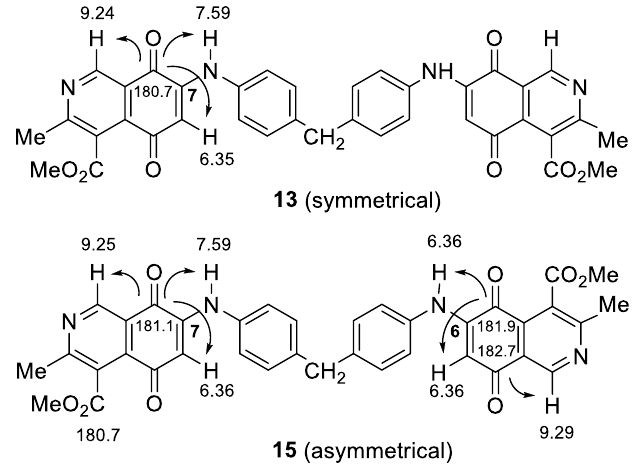
Figure 4. HMBC correlations of homodimers 13 and 15 .